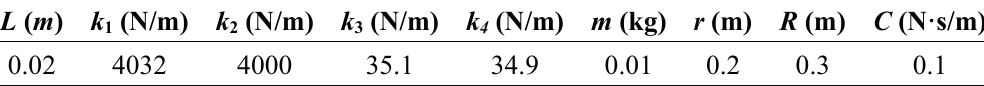
Table 4. Design parameters of the prototype in COMSOL.